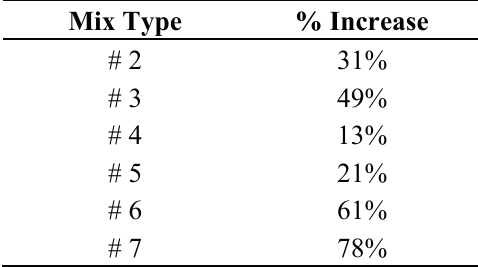
Figure 5. Average compressive strength results for GCEB mixes. Table 5. Percentage increase in compressive strength.